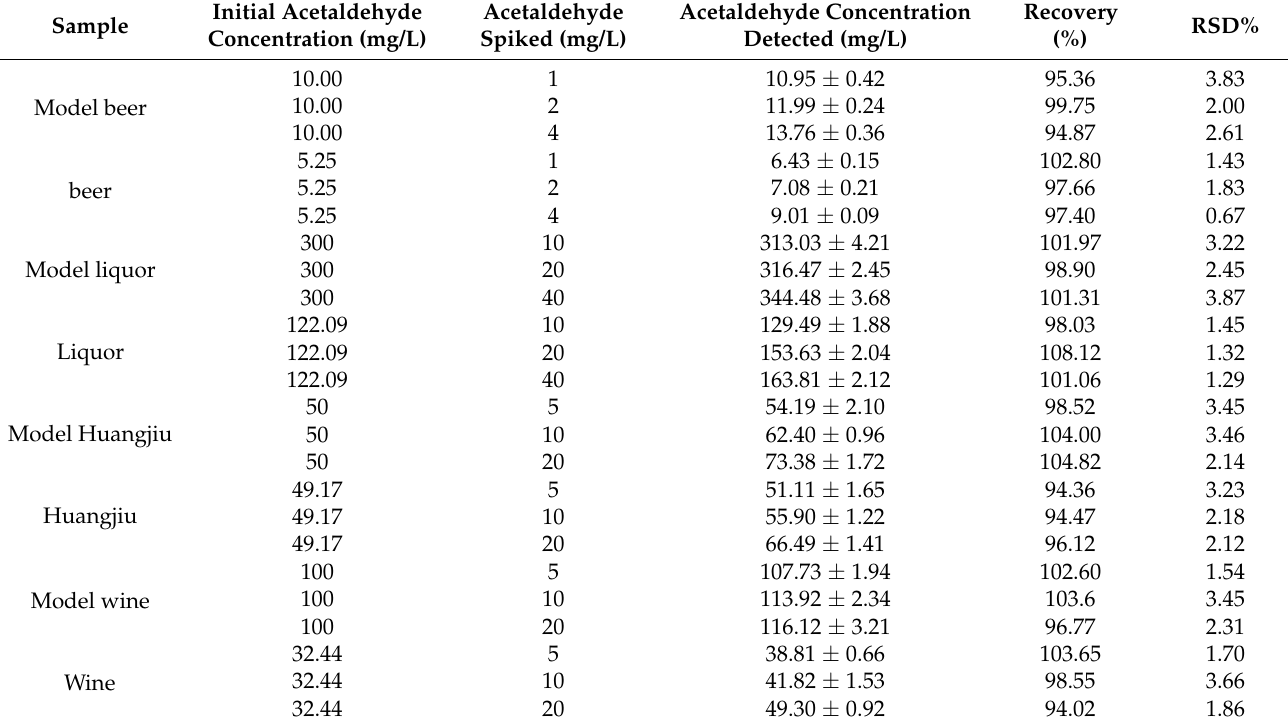
Table 1. The recovery and RSD of the fluorescence sensing method with